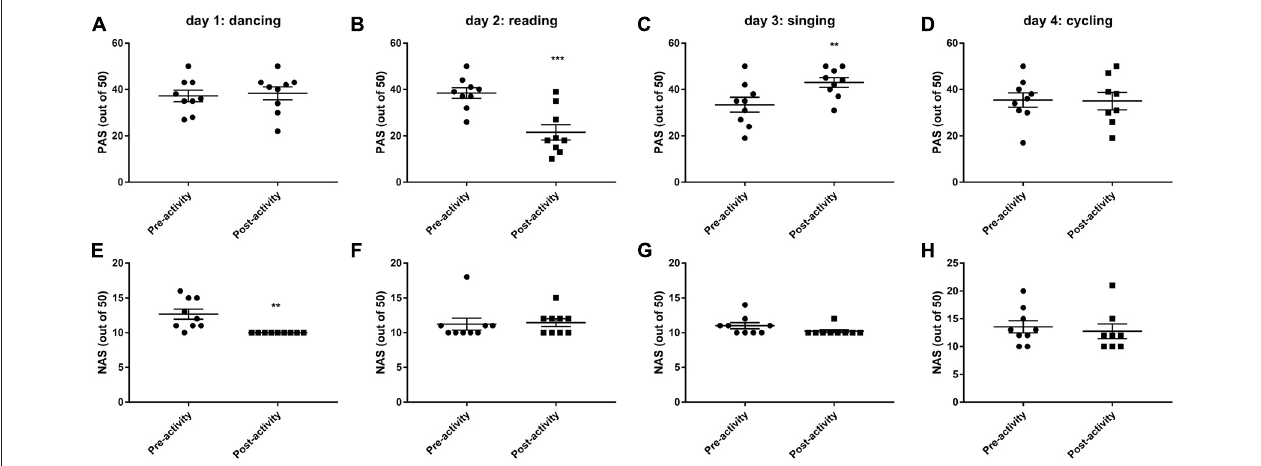
FIGURE 3 | Changes in postive (PAS, A–D ) and negative (NAS, E–H ) mood and emotions before and after 30 min activity (dancing, reading, singing or cycling) in nine healthy female volunteers. Data is presented as a scatter plot with mean ± SEM. Data sets were compared by paired Student’s t -test pre and post-activity ( ∗∗ P < 0.01, ∗∗∗ P < 0.001).